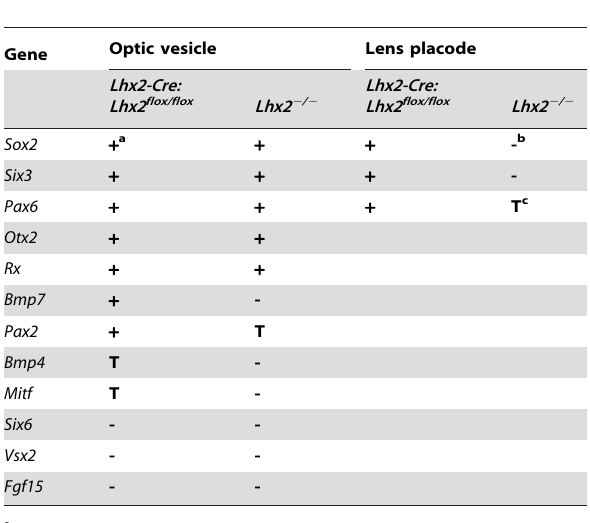
Table 1. Comparison of gene expression between Lhx2- Cre:Lhx2 flox/flox and Lhx2 2 / 2 embryos in the optic vesicle and lens